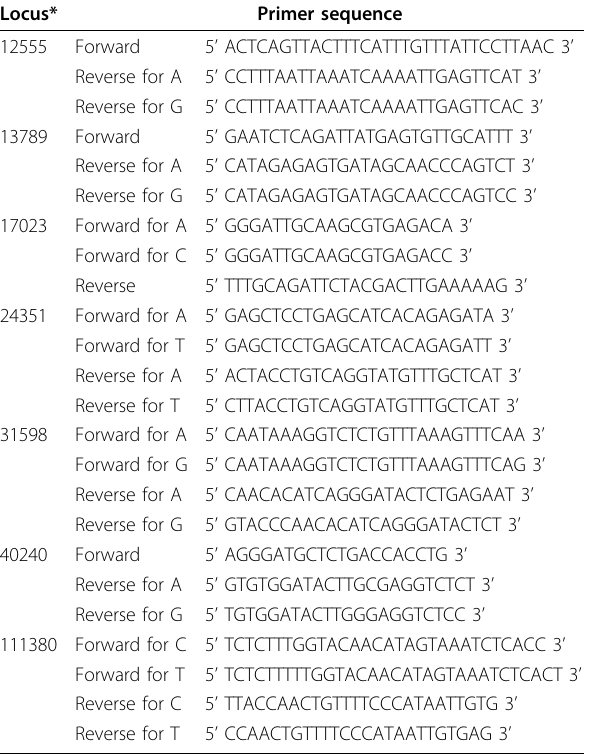
Table 3. When we performed logistic repression analysis using a recessive model adjusted for age and gender, 3